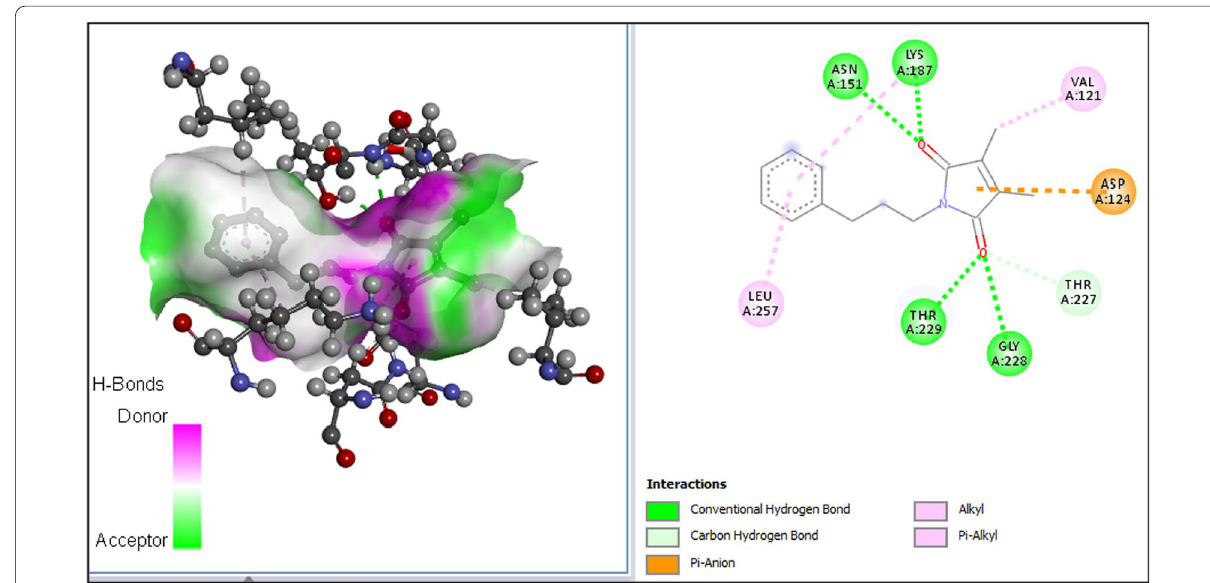
Fig. 6 2D and 3D view of the interaction between compound 21 and PdxK receptor